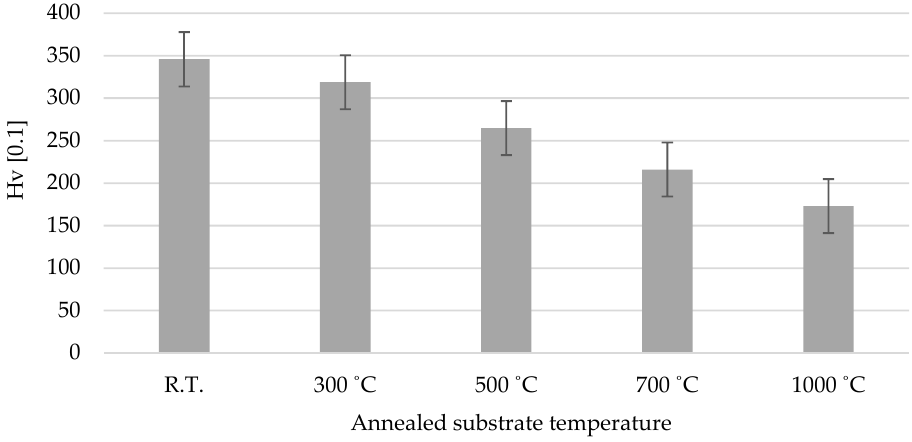
Figure 5. Annealed substrate microhardness of SUS 304 from room temperature to 1000 ◦ C